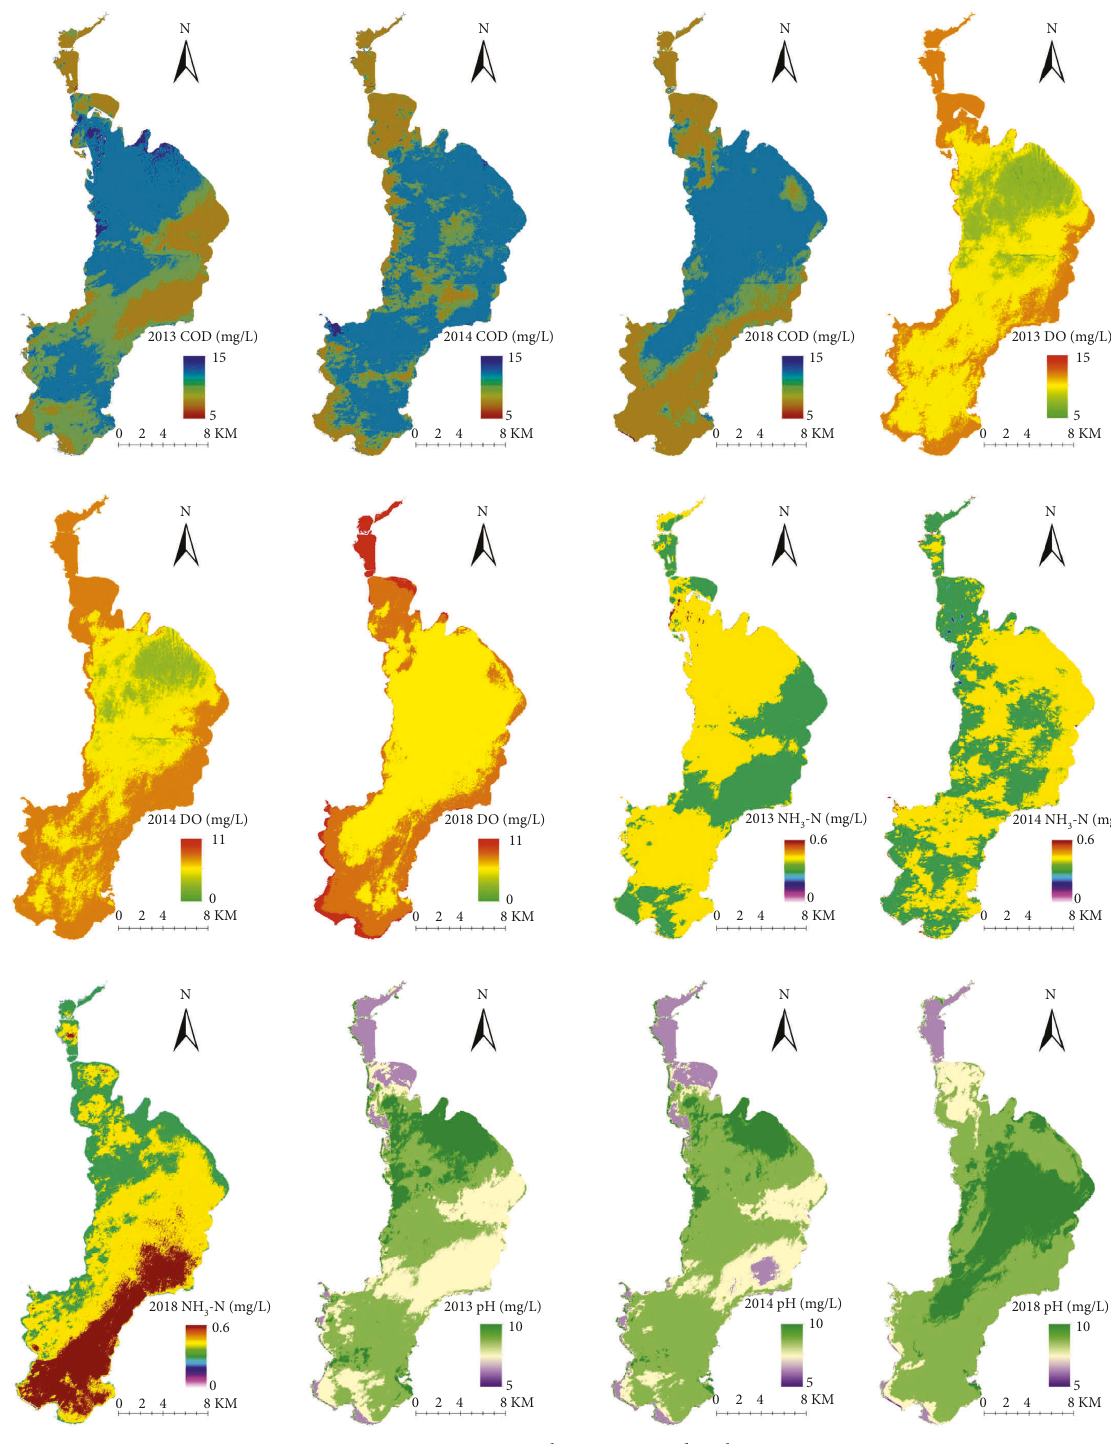
Figure 4: Water quality inversion